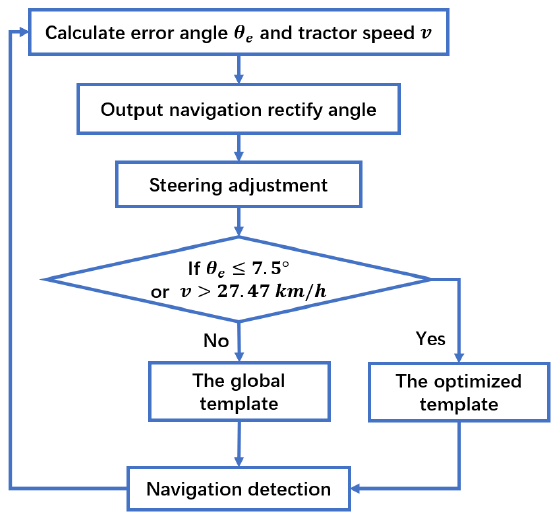
Figure 22. Template selection algorithm.